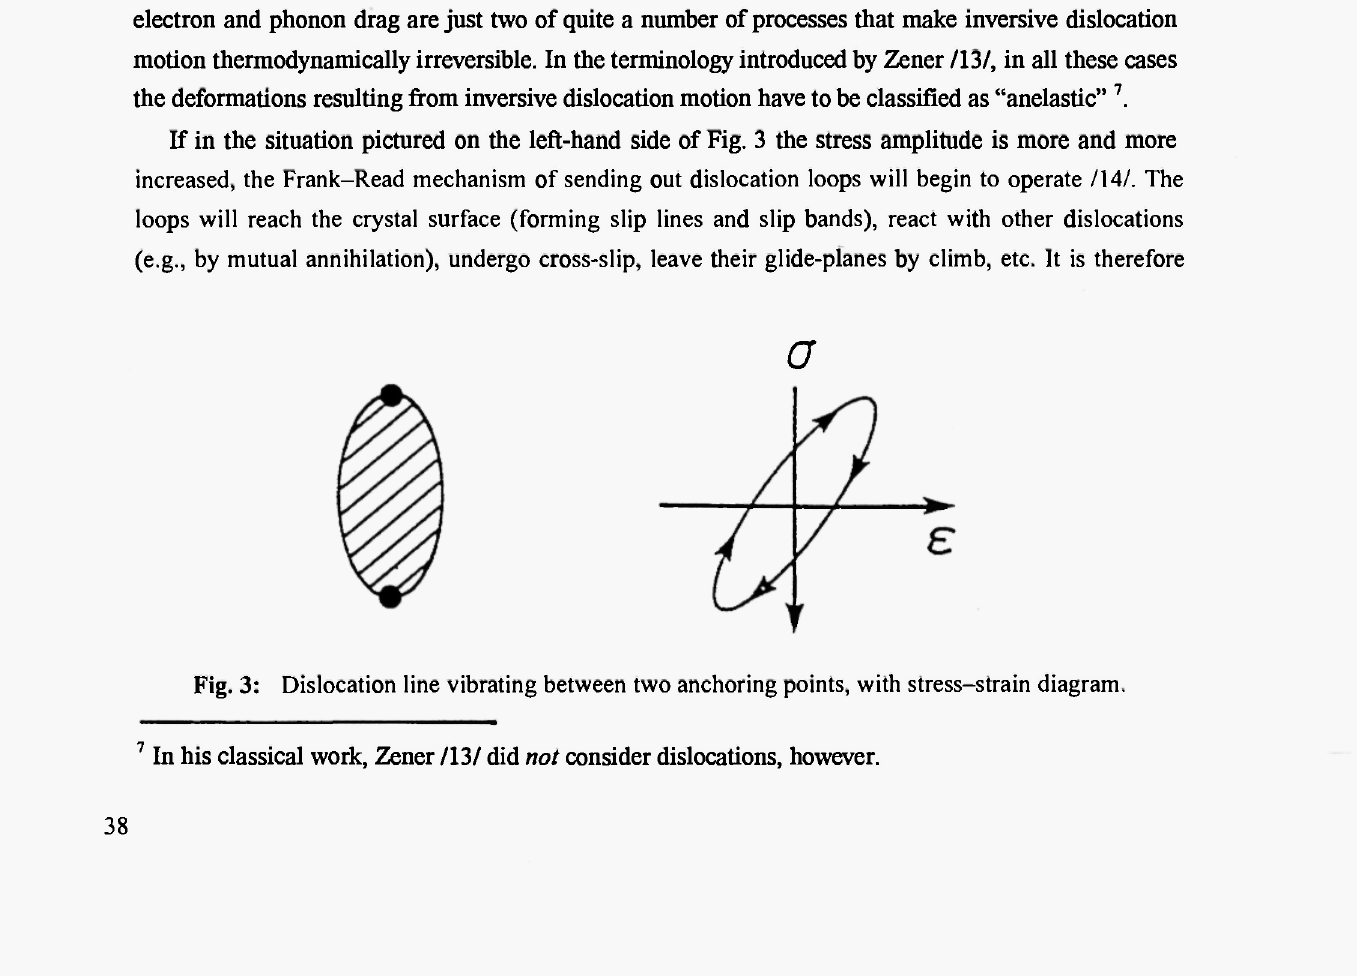
Fig. 3: Dislocation line vibrating between two anchoring points, with stress-strain